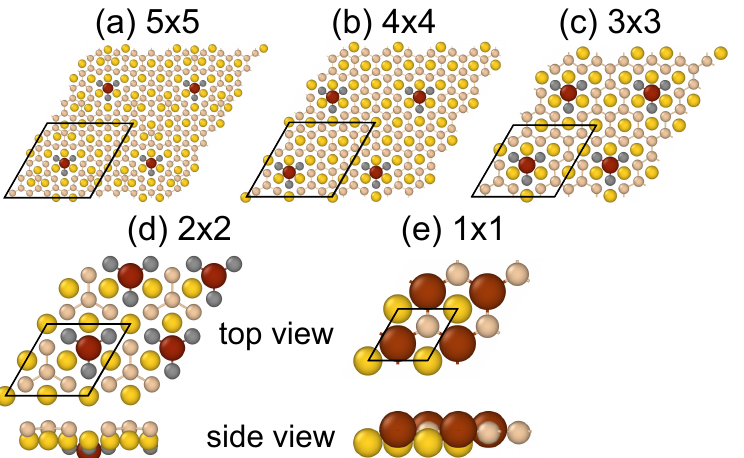
Figure 2. Atomic structures of Fe-substituted planar silicene/Au with a concentration of N = 2.0% ( a ), 3.1% ( b ), 5.6% ( c ), 12.5% ( d ), and 50.0% ( e ). Unit cells for each structure are marked by black rhombi.